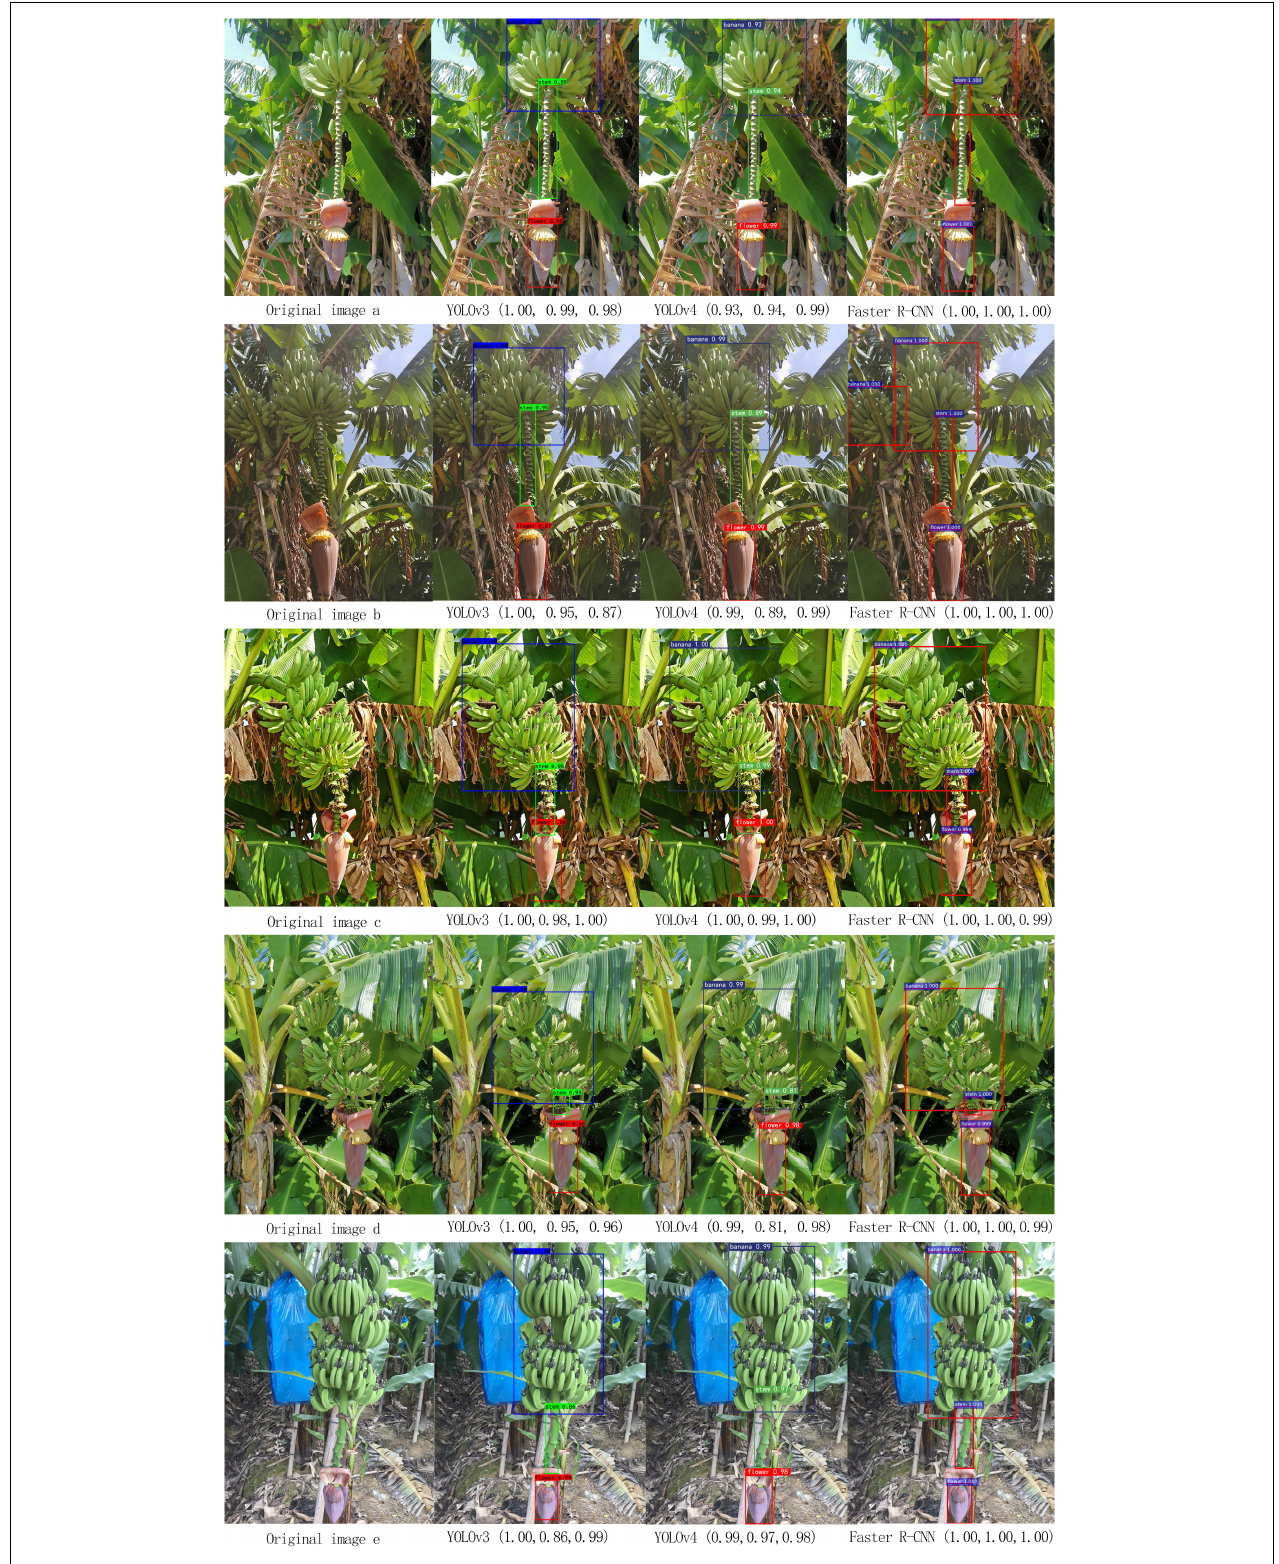
FIGURE 10 | Comparison of the multi-target recognition results of bananas.